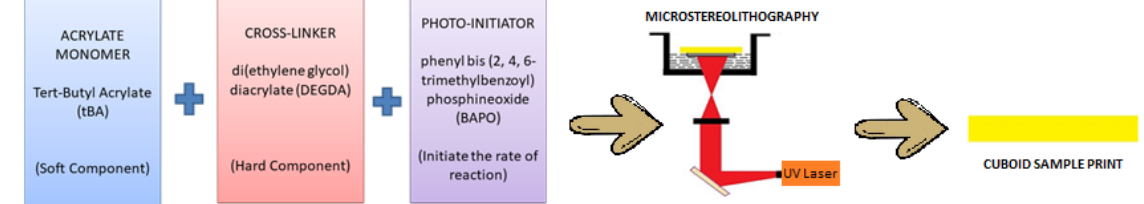
Figure 1. Sequential operations in cuboidal sample preparation by